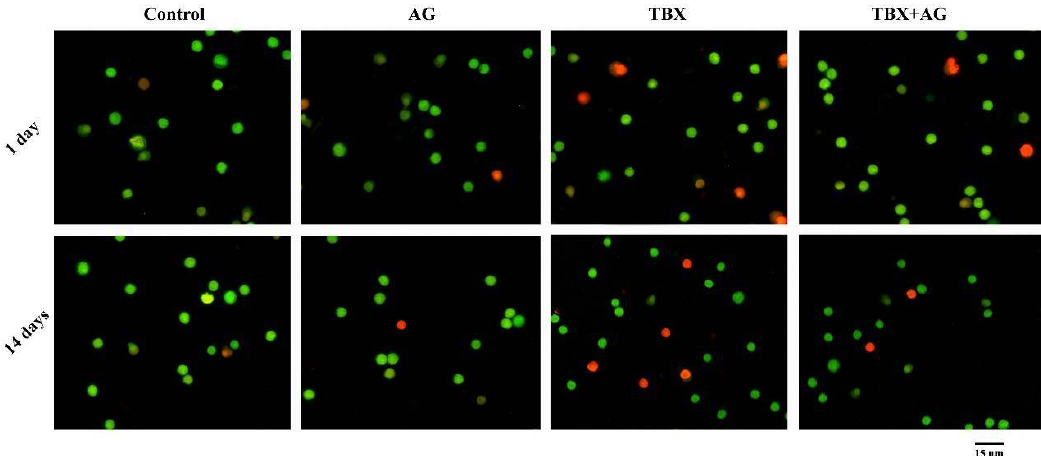
Figure 5. Representative photomicrographs show the protective effect of AG against TBX-induced cytotoxicity in peripheral blood leucocytes of treated rats after 1 and 14 days of the experiment. The isolated leucocytes were stained by AO/EB fluorescent dyes (Olympus CX23 microscope, Japan). AG: 10% Arabic gum, TBX: Telebrix (1600 mg/kg b.wt.) and TBX+AG: co-treatment with 1600 mg/kg b.wt. and 10% Arabic gum.